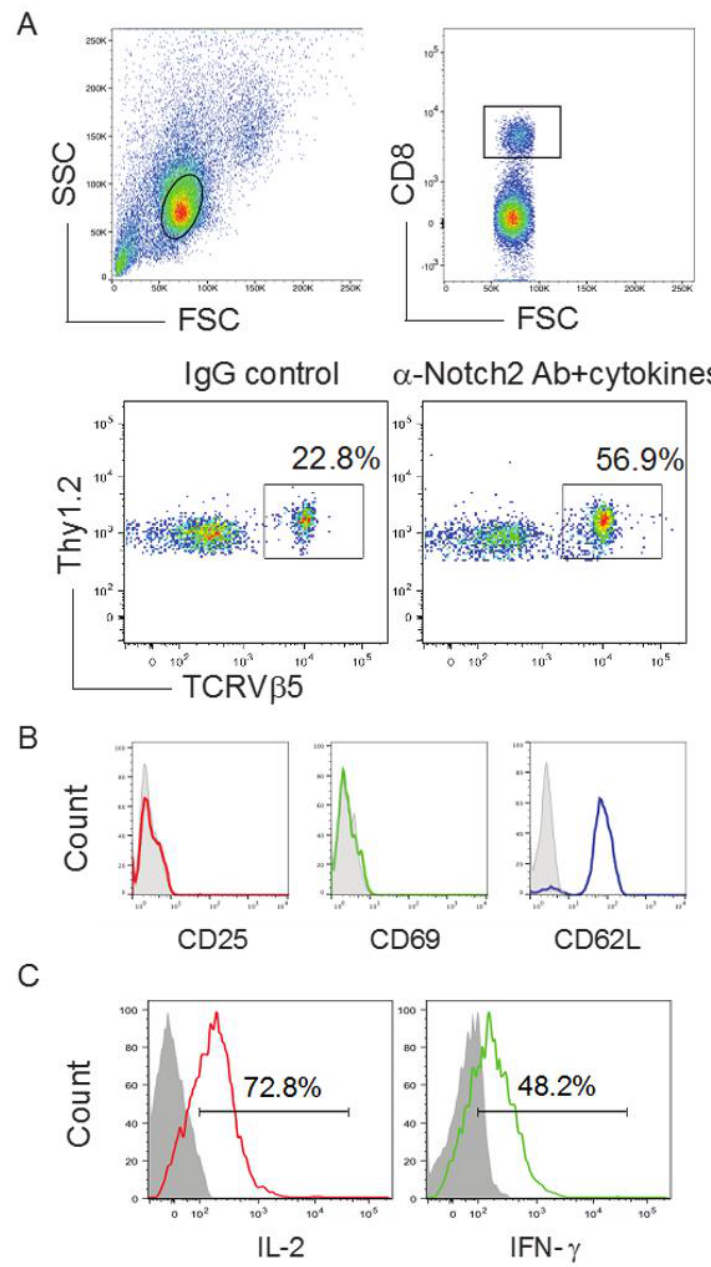
Figure 2. Development of Ag-specific CD8 + T cells by genetic modification of HSCs following in vivo priming. TCR gene-transduced HSCs (GFP + ) in PBS were sorted, before being adoptively transferred into Thy1.1 congenic mice. On the following week, mice were i.p. injected with agonistic α-Notch2 Ab, rIL-7 and rFlt3L or a mouse IgG/PBS control. ( A ) After another two weeks, Thy1.2 + TCRVβ5 + cells from the pooled LNs and spleen were analyzed by flow cytometry, after gating on CD8 + T cell population (upper panels). A representative image from mice receiving the HSCs transduced with the Mig-TCR is shown, which was obtained after IgG control or agonistic α-Notch2 Ab, rIL-7 and rFlt3L protein injections. ( B ) Expression of CD25, CD69 and CD62L was analyzed by flow cytometry, after gating on CD8 + Thy1.2 + TCRVβ5 + T cells from the pooled LNs and spleen (dark lines; shaded areas indicate isotype controls). Data are representative of three independent experiments. ( C ) IL-2 and IFN-γ production (dark lines; shaded areas indicate isotype controls). The pooled LNs and spleen were stimulated with OVA 257–264 peptide and analyzed by intracellular cytokine staining, after gating on Thy1.2 + TCRVβ5 + cells. Data are representative of three independent experiments.